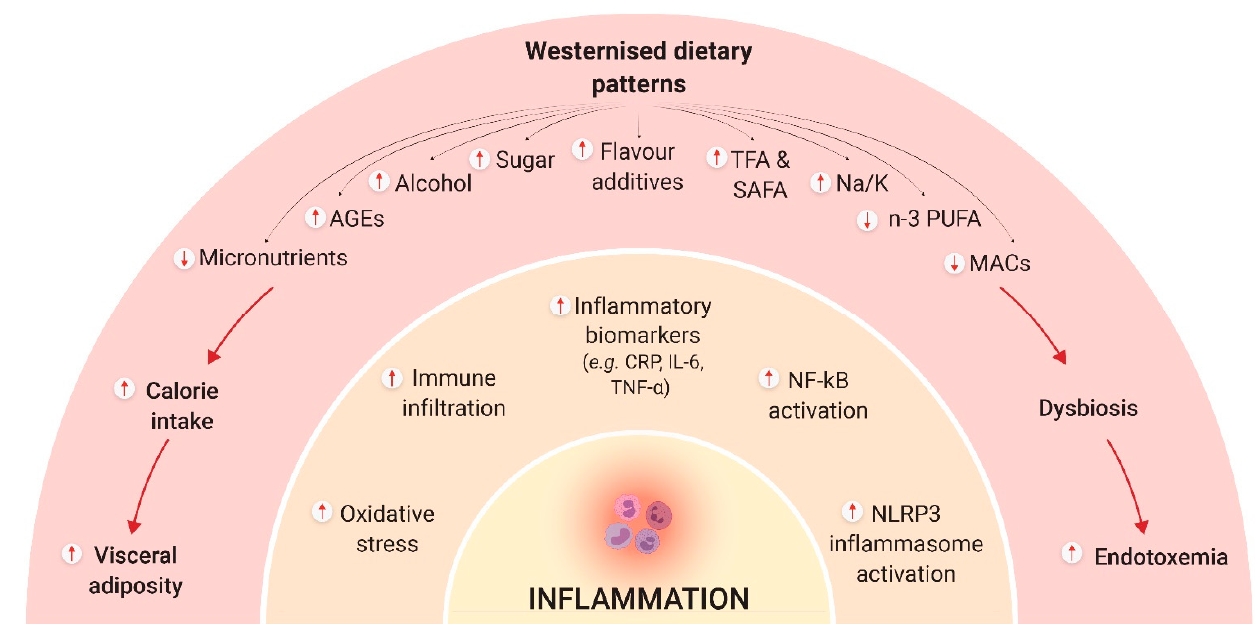
Figure 2. Summary of potential mechanisms underlying the deleterious effects of westernised dietary patterns on inflammation. Abbreviations: AGEs, advanced glycation end products; CRP, C-reactive protein; IL-6, interleukin-6; MACs, microbiota-accessible carbohydrates; NF- κ B, nuclear factor- κ B; PUFA, polyunsaturated fatty acids; SAFA, saturated fatty acids; TFA, trans fatty acids; TNF, tumor necrosis factor. Source: Self-elaboration based on the main results obtained in the scientific literature.